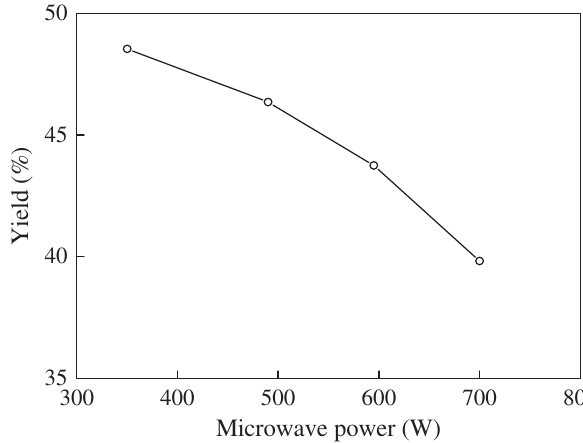
Figure 3: FTIR spectra of activated carbon at different microwave power from waste bamboo.